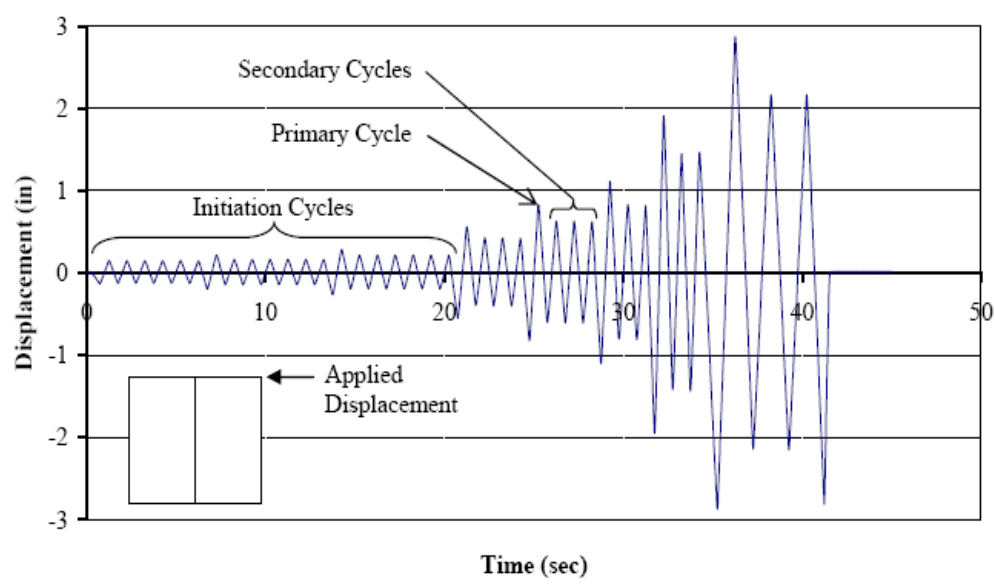
Figure 4. Shearwall loading